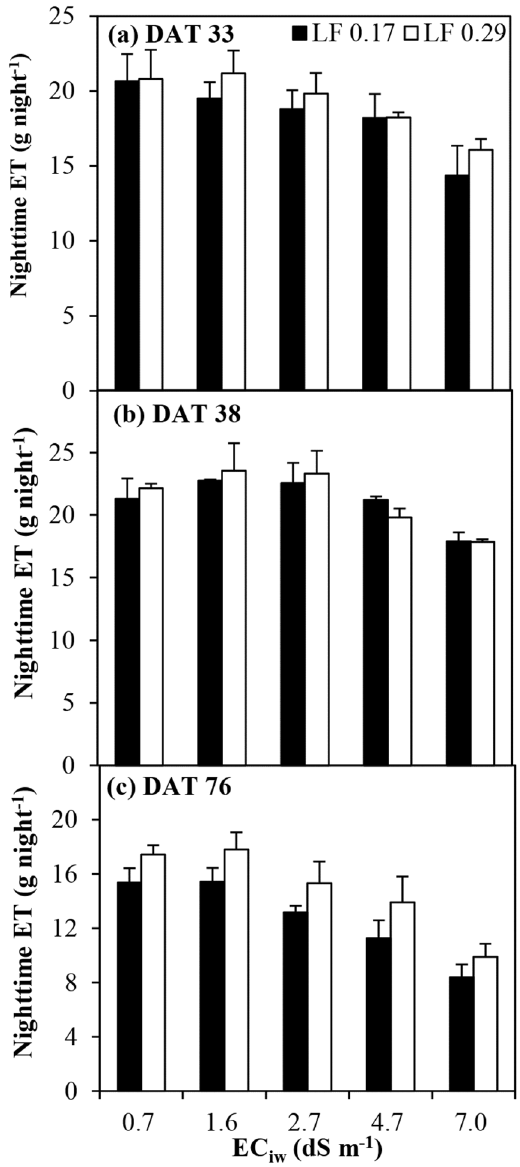
Figure 3. Variation of nighttime evapotranspiration (ET) under various irrigation water salinity levels (EC iw ) and leaching fractions (LF). The error bars indicate standard deviation of nighttime ET. DAT represents days after transplanting.